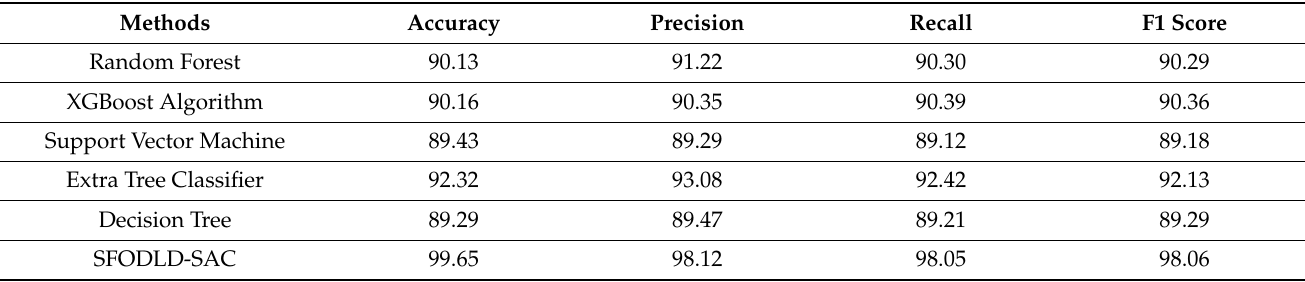
Table 5. Comparative analysis of SFODLD-SAC technique with existing approaches.